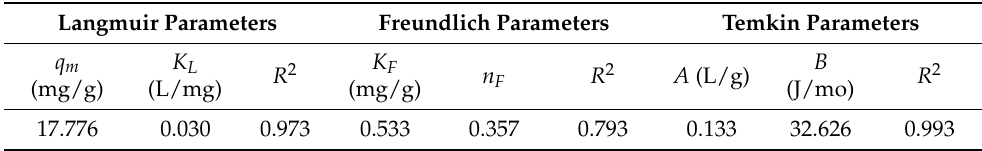
Figure 10. Isotherm models for diazinon adsorption onto MIP-202/CA composite beads. Table 1. Isotherm parameters of Langmuir, Freundlich, and Temkin models for the diazinon adsorp- tion onto the synthesized MIP-202/CA composite